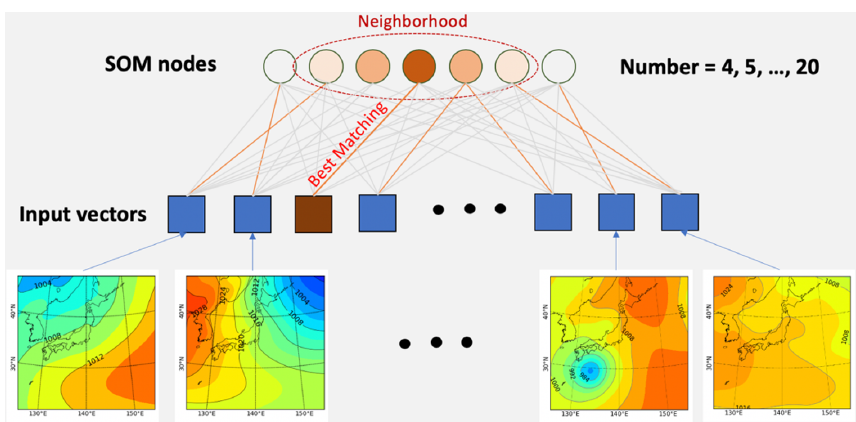
Figure 2. Illustration of SOM configuration and simulation settings. Used data are daily (at 00:00UTC) ERA-Interim sea-level pressure (from 1 January 1979 to 1 December 2019) divided into four seasons: winter (December–January–February), spring (March–April–May),